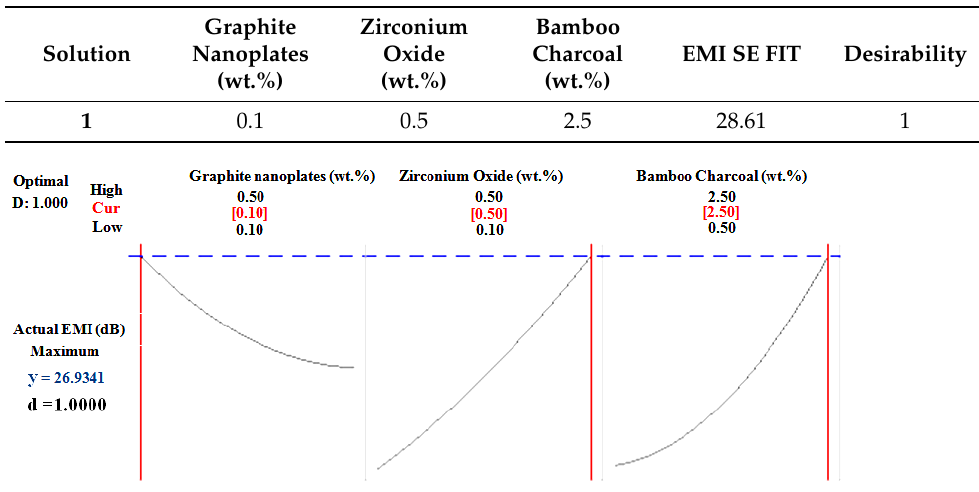
Table 9. Optimum wt.% of graphite nanoplates, zirconium oxide and bamboo charcoal.